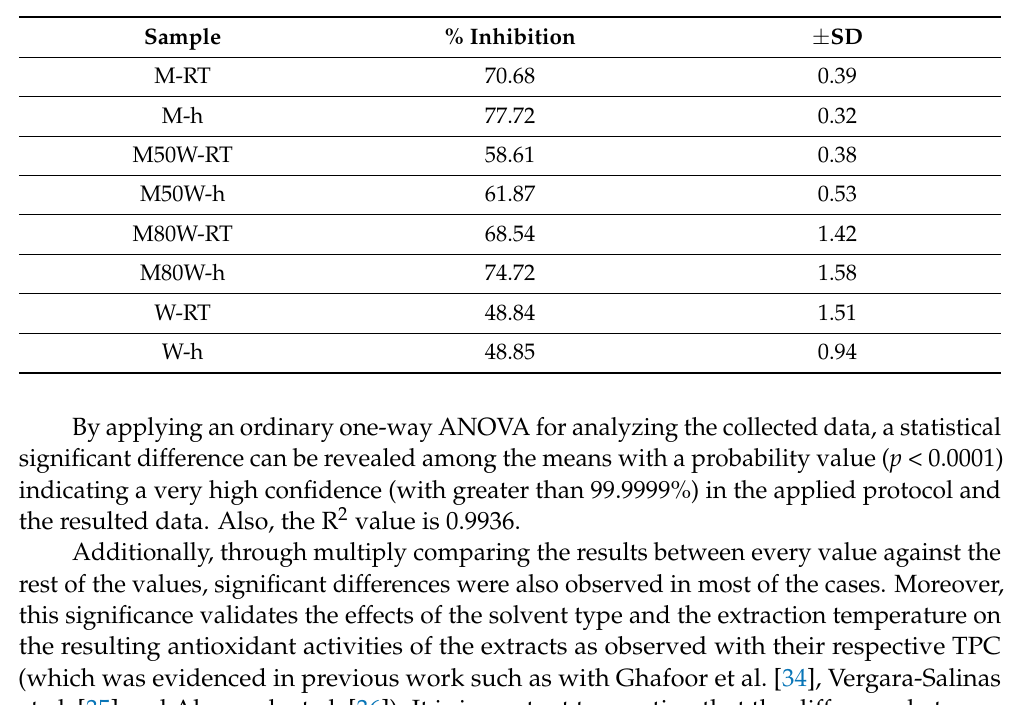
Table A3. The results of DPPH assay expressed as percentage inhibition.